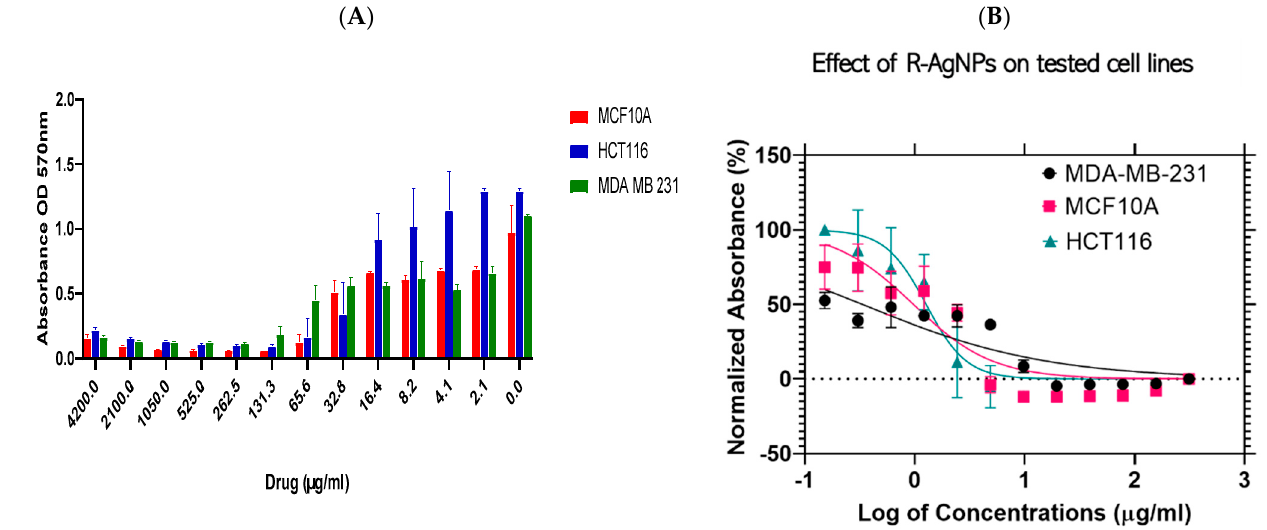
Figure 12. Effect of R- AgNPs on the cell viability of normal and cancer cells. Bar graph showing dose relationship of R- AgNPs on the viability of two human cancer cell lines; HCT116 ( ) and MDA-MB-231 ( ) and a normal cell line; MCF 10A ( ) ( A ). Log dose-response relationship of R-AgNPs on the normalised viability of two human cancer cell lines; HCT116 ( ) and MDA-MB-231 ( ) and one normal cell line MCF 10A ( ) ( B ). IC 50 values of AgNPs on each cell line was calculated using Log viability vs. normalised response − variable slope (four-parameter).